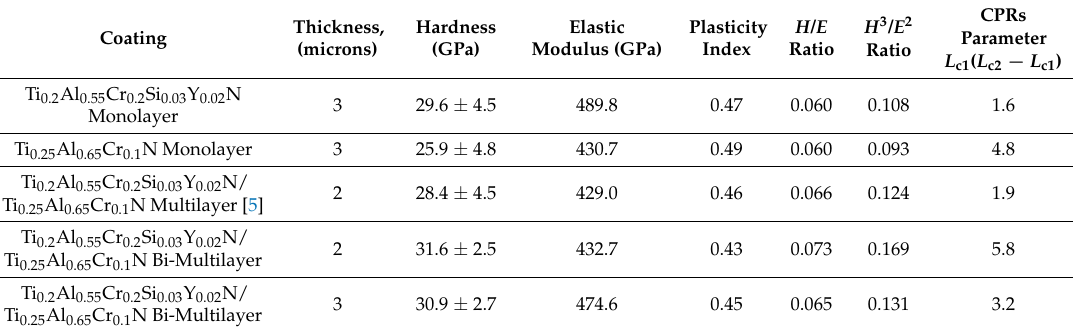
Table 3. Micro-mechanical properties of the studied coatings.